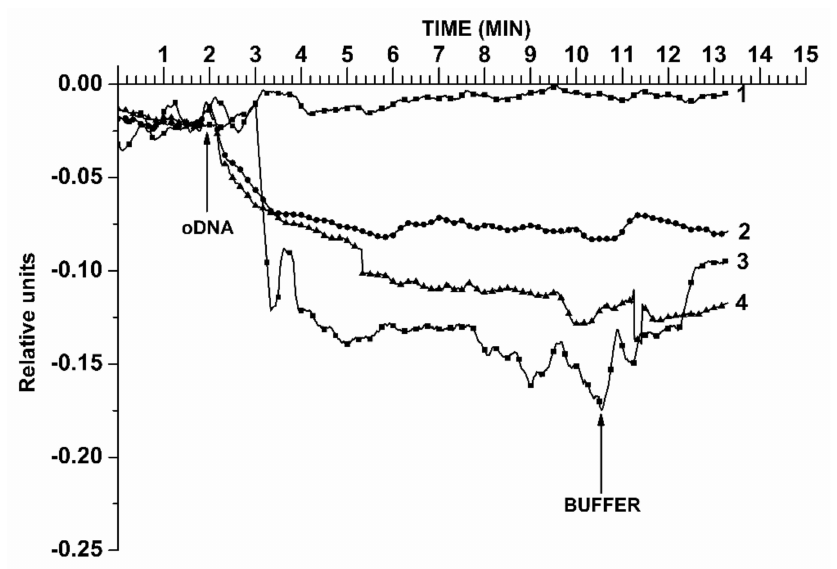
Figure 5. Typical sensograms obtained during the detection of oDNA analogue of circNFIX RNA in pure buffer solution, at various concentrations. Experimental conditions: target oDNA concentration 1.1 × 10 − 18 M (curve 1), 1.1 × 10 − 17 M (curve 2), 1.1 × 10 − 16 M (curve 3), or 1.1 × 10 − 15 M (curve 4); 1 mM potassium phosphate buffer (pH 7.4); V g = +40 V; V ds = 0.1 V. The total volume of the analyzed solution in the measuring cell was 450 µ L. The time points of the addition of target oDNA solution and the wash of the sensor surface with pure potassium phosphate buffer are indicated by